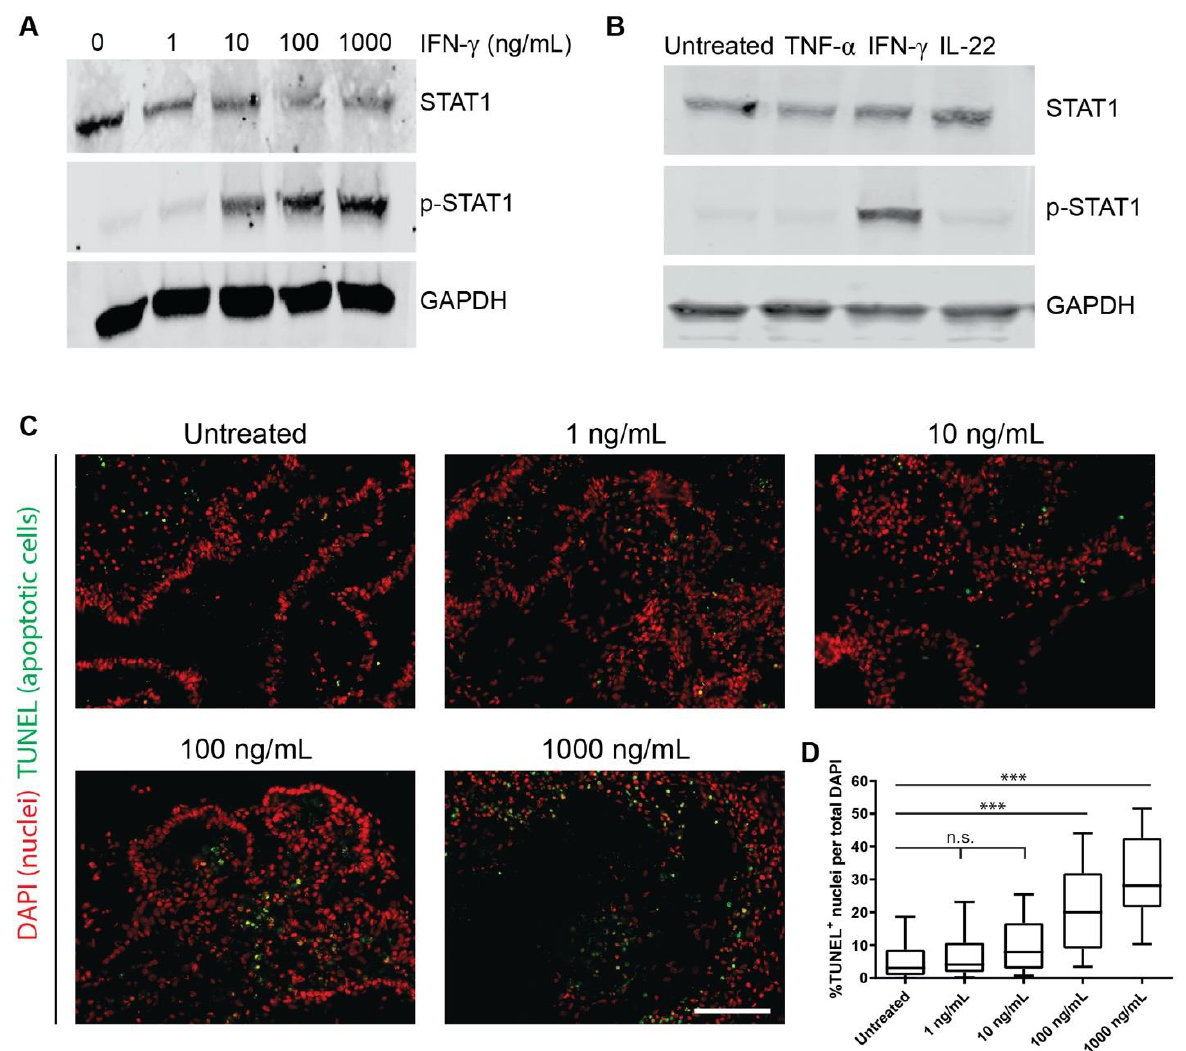
Figure 1. iPSC-derived intestinal organoids are responsive to interferon-gamma (IFN- γ ). ( A ) Representative Western blot showing detection of STAT1, phosphorylated STAT1 (p-STAT1), and GAPDH loading control reveals that human intestinal organoids (HIOs) treated for 1 h with IFN- γ concentrations of 10 ng/mL and greater exhibit robust phosphorylation of STAT1. ( B ) Phosphorylation of STAT1 is specific to IFN- γ treatment. ( C ) Representative images of HIOs stained with TUNEL and DAPI. Scale Bar = 100 µ m ( D ) Quantification of TUNEL+ nuclei in HIOs treated for 3 days with IFN- γ , showing an increase in apoptosis in HIOs treated with 100 ng/mL and 1000 ng/mL IFN- γ versus untreated controls. Plots represent the combined data from 3 independent HIO differentiations and IFN- γ treatments ( n = 24 to 32 analyzed sections per treatment group). Boxes represent the 25th to 75th percentiles, whiskers represent the 10th to 90th percentiles, and the bar represents the median. *** p < 0.001, n.s.—not significant, ANOVA with Dunnett’s multiple comparisons test comparing each group to Untreated.